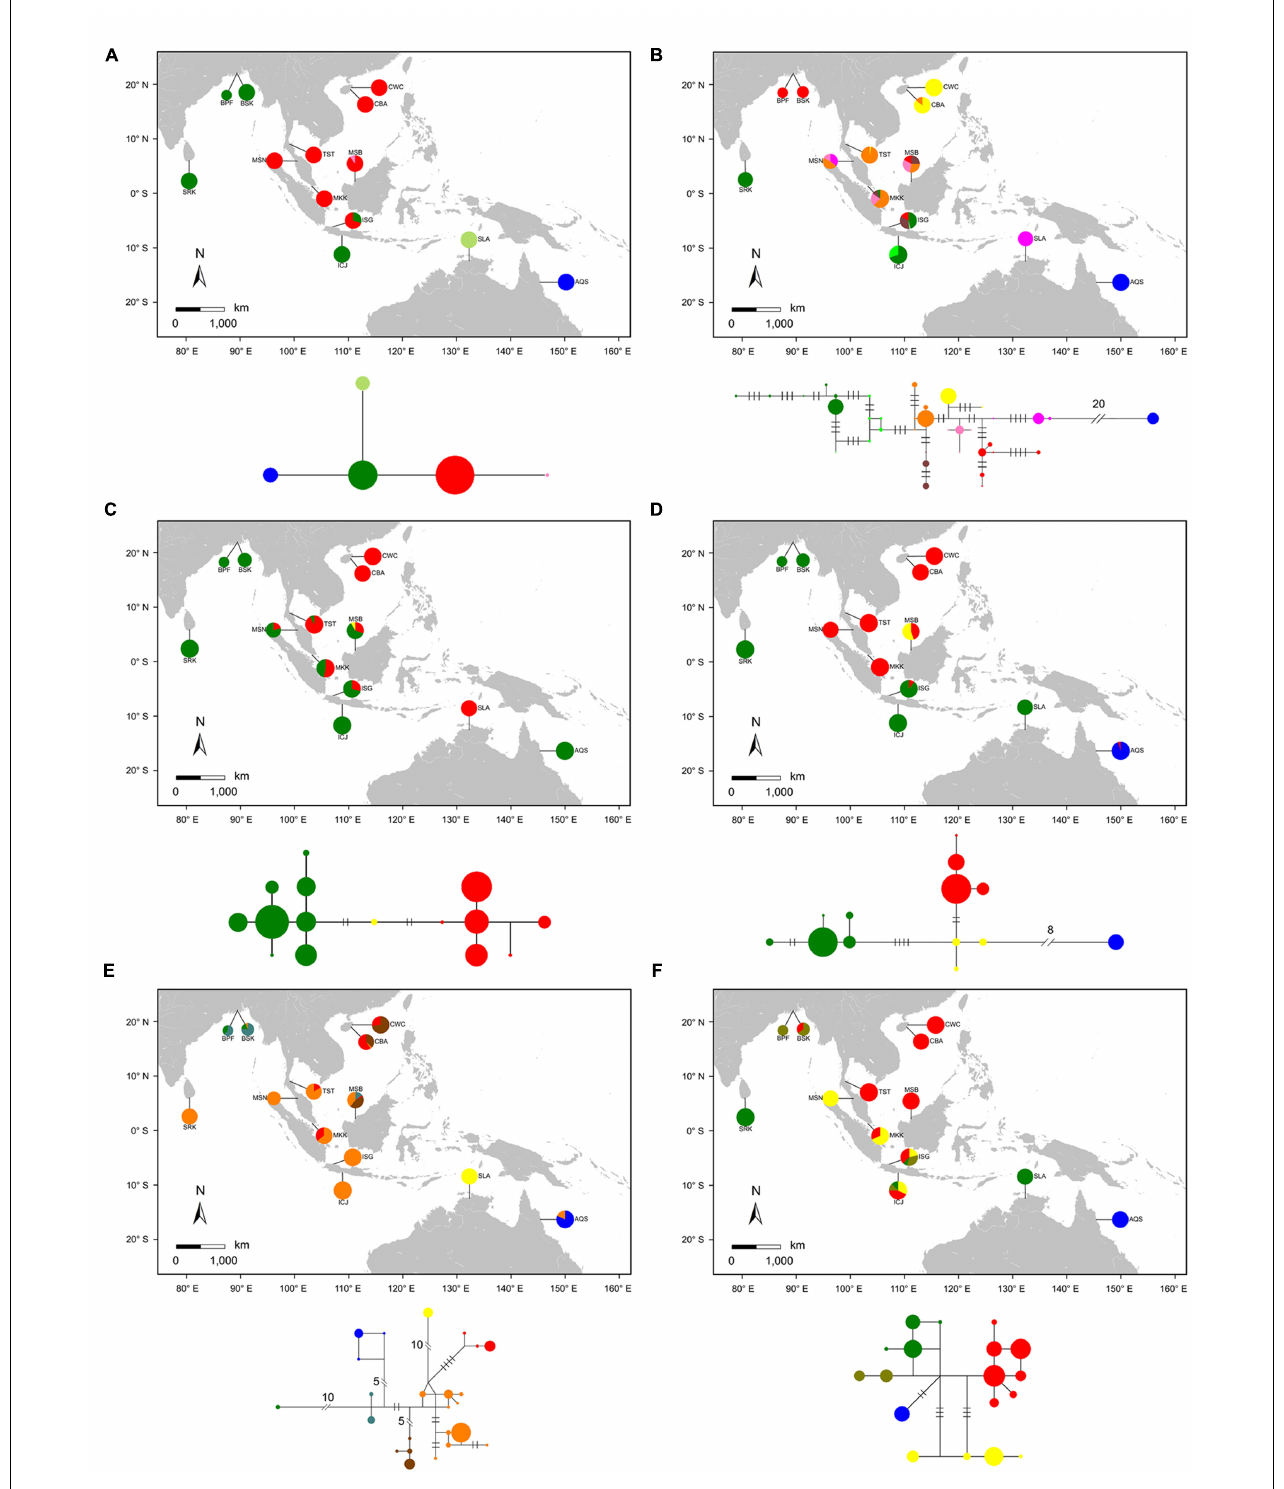
FIGURE 2 | Geographic distribution of haplotypes and Median-Joining network for the combined chloroplast fragments (A) and five nuclear genes (B: rpl9 , C: cpi , D: ppi , E: phi, and F: nhx2 ) in the 12 populations of Sonneratia caseolaris and the single population of S. lanceolata . Each haplotype was represented by a single circle whose size reflects haplotype frequency. Haplotypes with close relationships are marked with the same color. Each branch with more than one mutational step is labeled. Population abbreviations are defined in Table 1 .